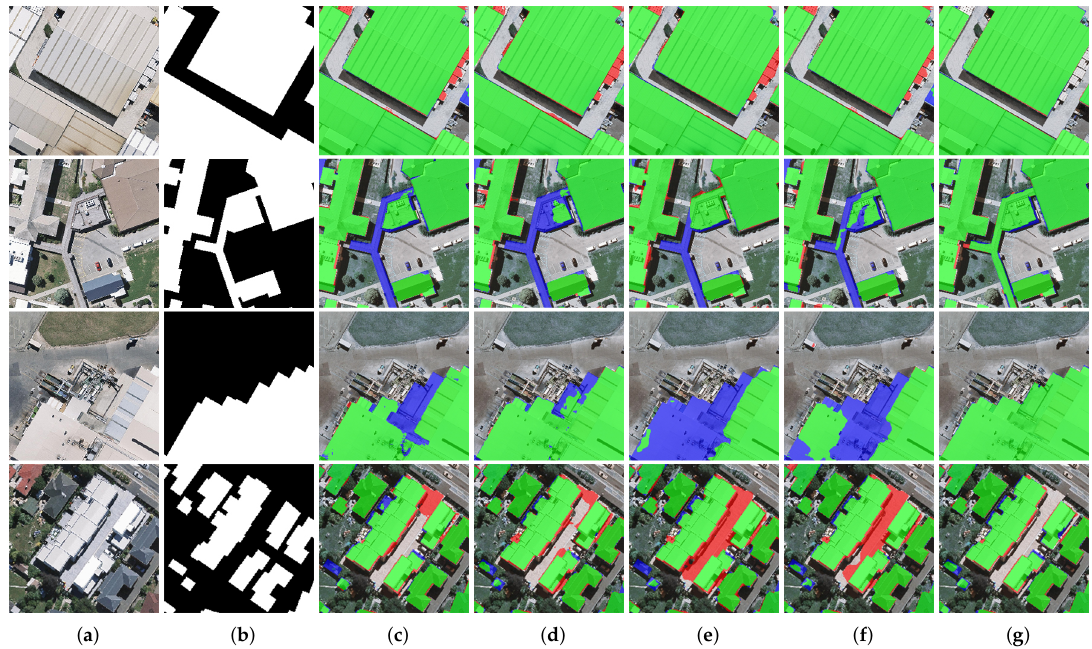
Figure 8. Close-up views of the results obtained by different methods on the WHU dataset. Images and results shown in ( a – g ) are the subset from the selected regions marked in Figure 7a. ( a ) Original image. ( b ) Ground-truth. ( c )